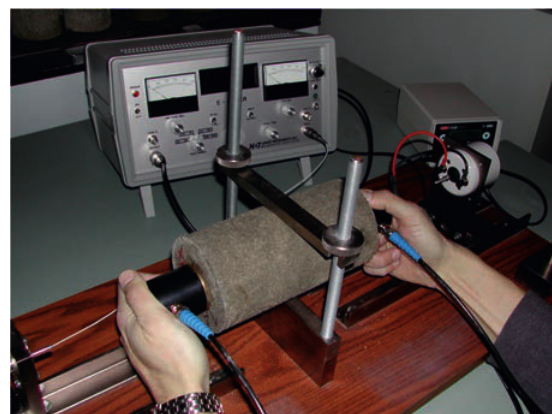
Fig. 1. Ultrasonic velocity measurement: a – schematic overview; b – measuring equipment